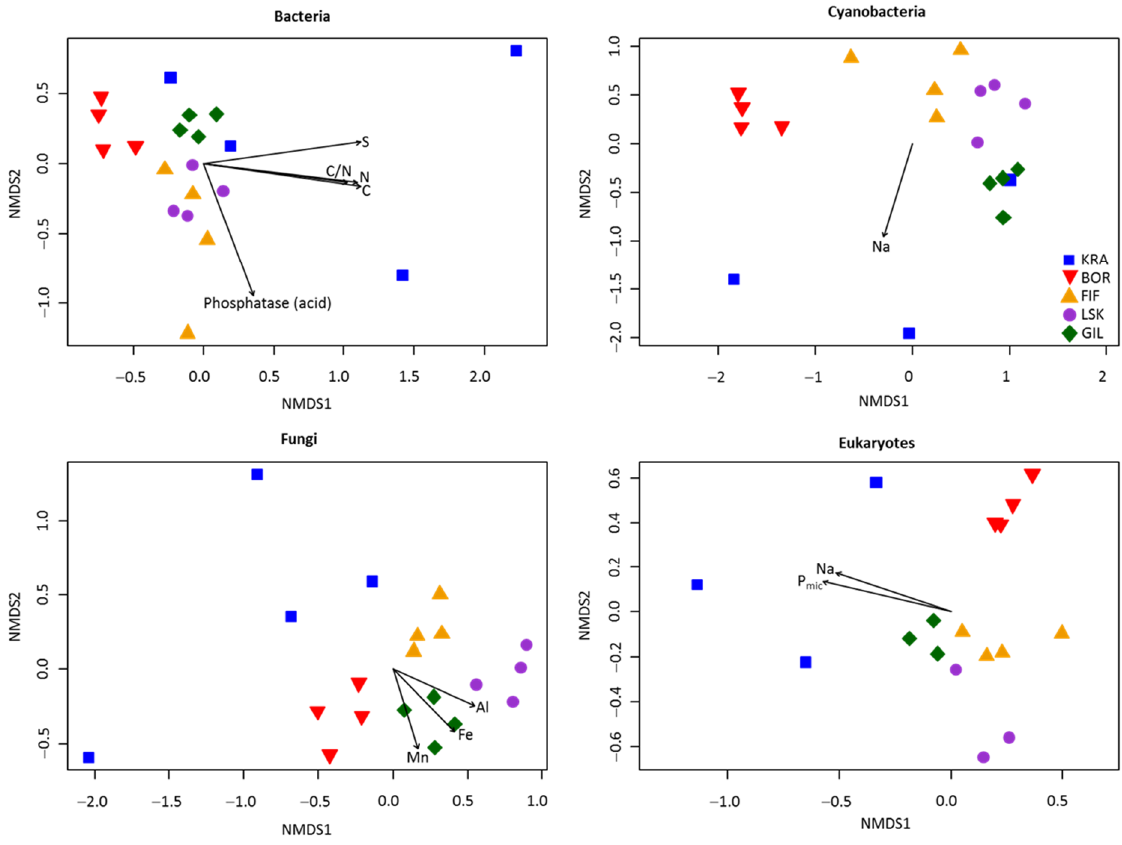
Figure 4. Non-metric multidimensional scaling (NMDS) plots based on relative abundance of the OTUs in the biocrusts. Arrows indicate significant correlations ( p < 0.05) with environmental variables. Phosphatase (acid), P mic , C, and N refer to the potential activity of acid phosphatase, microbial P, total organic carbon, and total organic nitrogen, respectively.